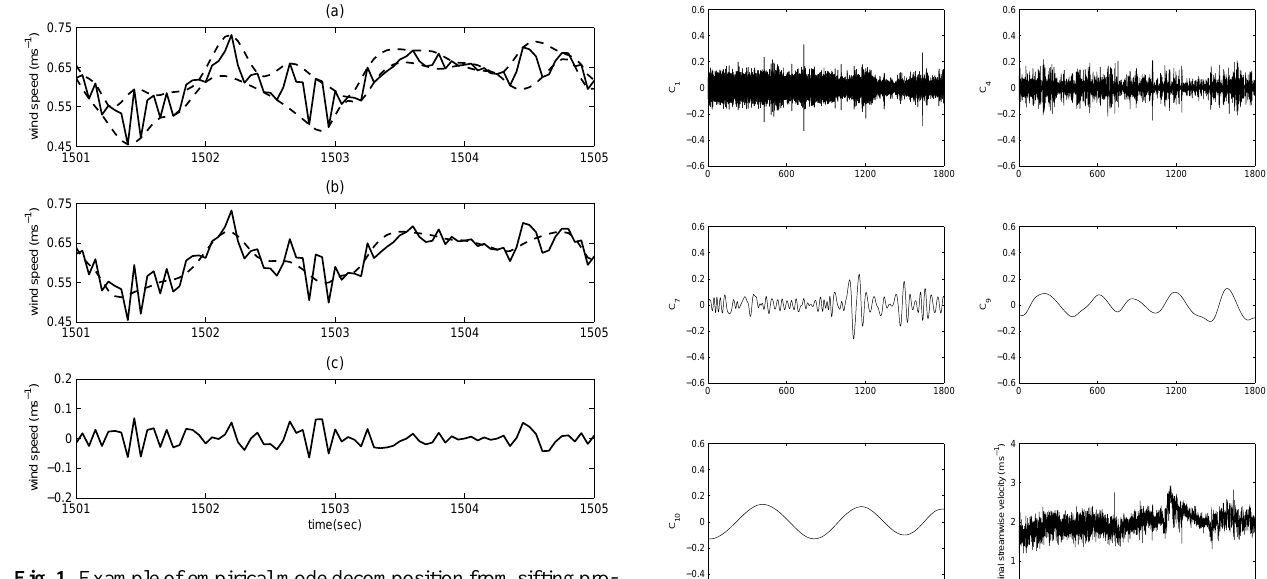
Fig. 1. Example of empirical mode decomposition from sifting pro- cess (from Eqs. 1 to 6). The solid line in (a) is a portion of the original vertical wind and the two dash lines are envelope curves, respectively. The dash line in (b) is the mean of two envelop curves. The solid line in (c) is the data after the first IMF has been removed.